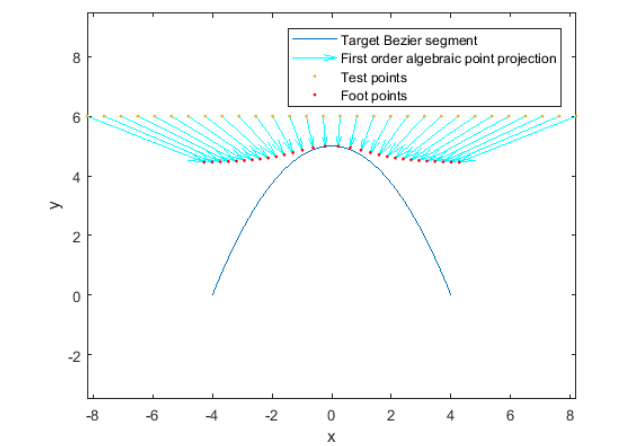
Figure 8. First-order algebraic point projection fails to reach footpoints on the curve for test points not close to quadratic Bézier